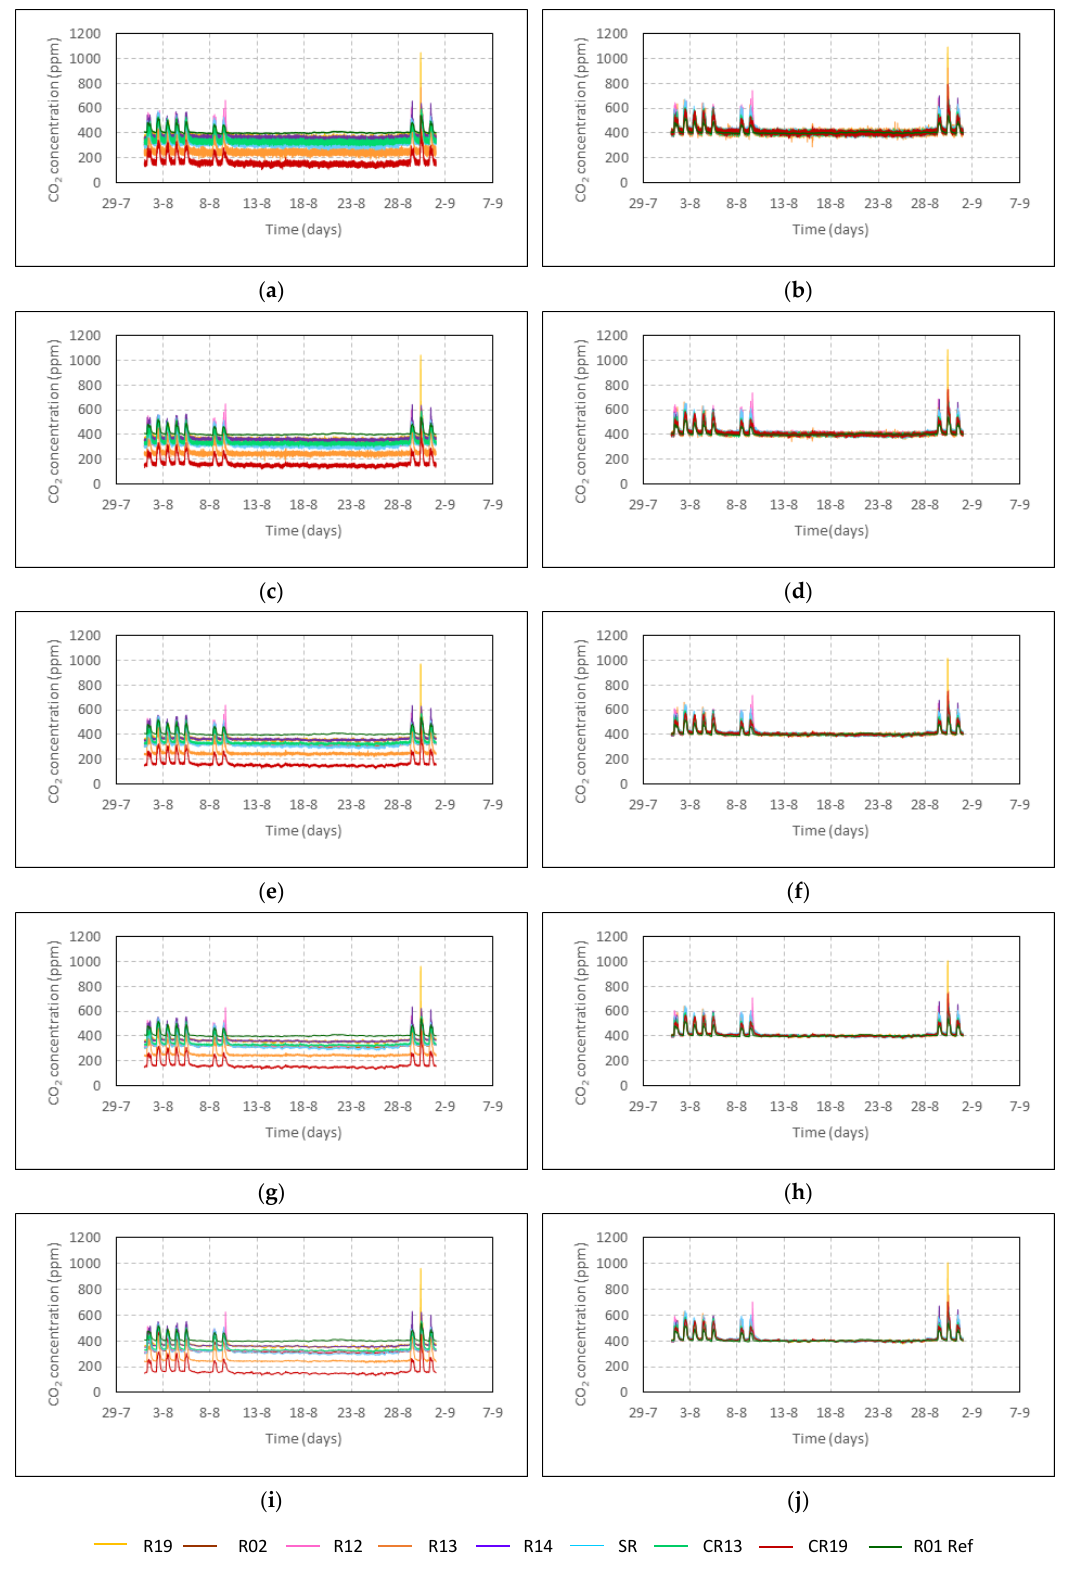
Figure 5. Summer 2016 as an example. The 14 years show similar behaviour. Raw data ( a ) and data averaged at intervals of ( c ) 2 min, ( e ) 5 min, ( g ) 10 min and ( i ) 30 min and calibrated measures with sensor R01 Ref for raw data ( b ) and the same average intervals ( d , f , h , j ),